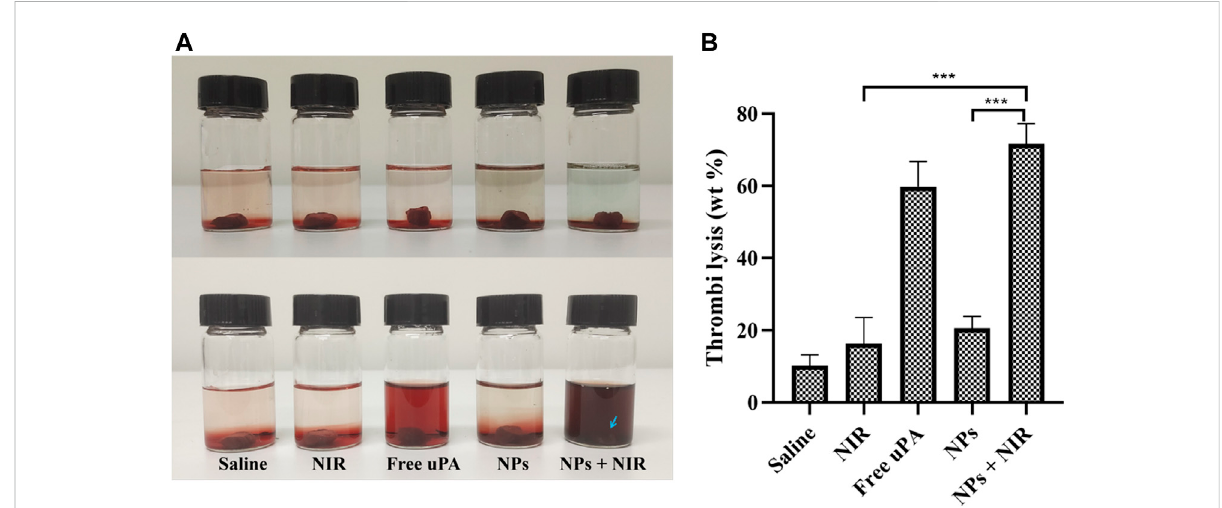
FIGURE 6 (A) Representative photos of thrombus treated with saline, saline with NIR irradiation (1 W/cm 2 ), free uPA (20,000 U/ml), cRGD-ICG-uPA NPs (20,000 U/ml), and cRGD-ICG-uPA NPs combined with NIR laser irradiation (20,000 U/ml; 1 W/cm 2 ). (B) The weight loss of thrombus in corresponding groups of in vitro thrombolysis test after 4 h ( n = 3). Data were represented as mean ± standard deviation (SD) ***p <